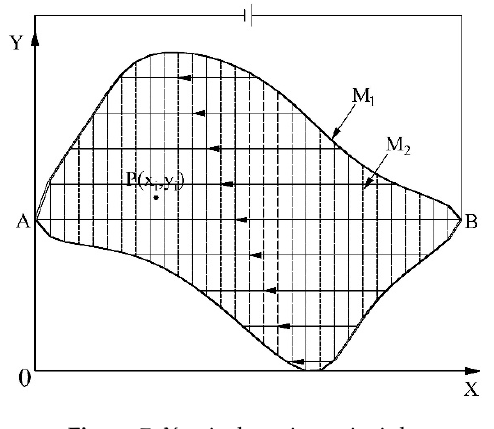
Figure 7. X-axis detecting principle.